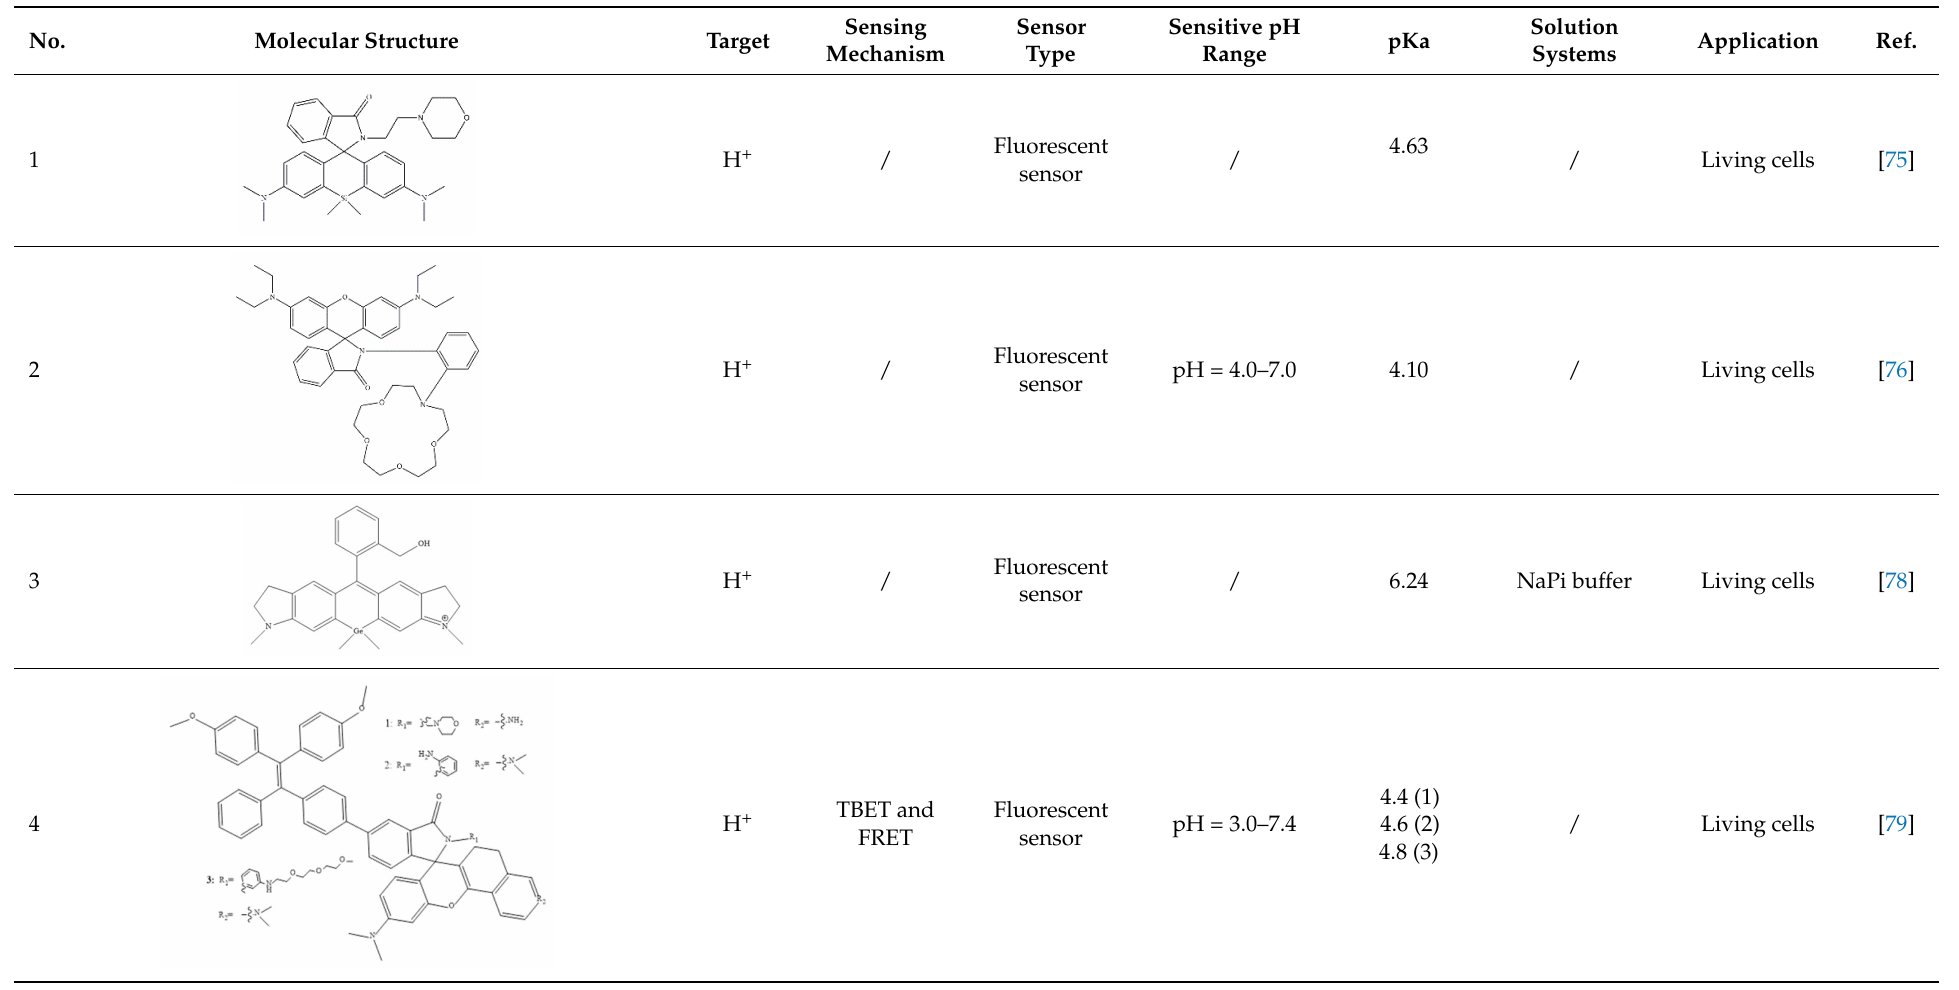
Table 2. Rhodamine-based sensors for H +